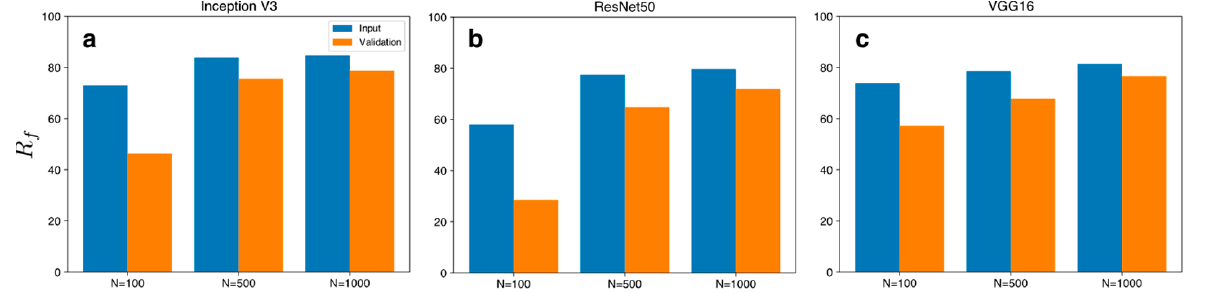
Figure 3. Effect of input dataset size on the fooling rates R f (%) of UAPs against Inception V3 ( a ), ResNet50 ( b ), and VGG16 models ( c ) for skin lesion image dataset. The values of R f for both the input and validation datasets are shown.